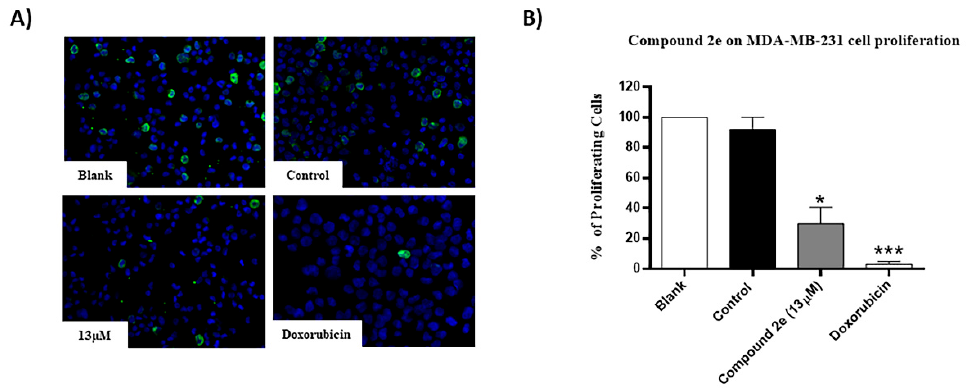
Figure 2. Effect of compound 2e on MDA-MB-231 cellular proliferation, determined by bromodeoxyuridine (BrdU) incorporation assay. Cells were treated for 48 h with medium (Blank), control (DMSO; vehicle), compound 2e (at 13 µ M) and Doxorubicin (positive control; 50 nM). ( A ) Representative fluorescence microscopy images of BrdU incorporation (green) and DAPI stained nuclei (blue). Amplification = 200×. ( B ) Percentage of BrdU-incorporating cells. The results are presented as the mean ± S.E.M. of three independent experiments. * p ≤ 0.05 and *** p ≤ 0.001 of Control vs. Treatments.